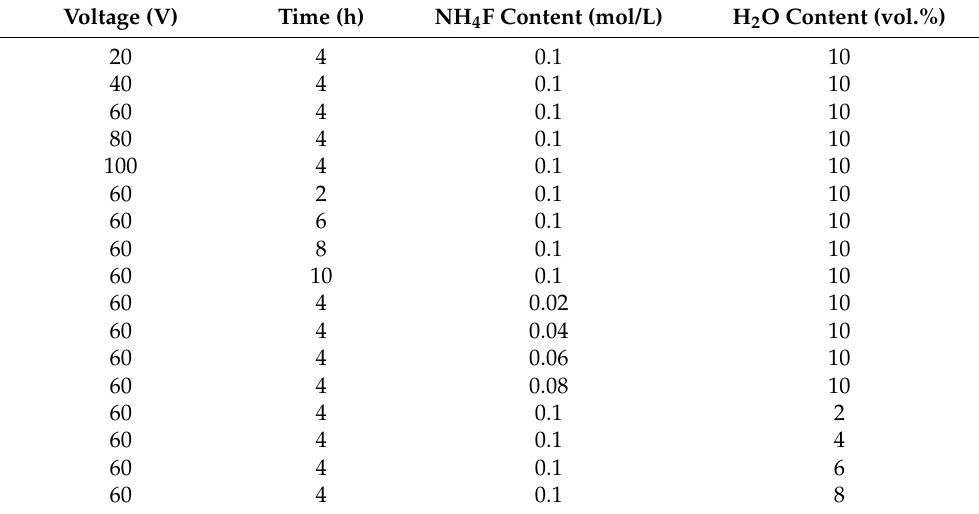
Table 1. Detailed experimental parameters including various anodization conditions (applied volt- ages and time) and bath compositions (fluoride concentration and water